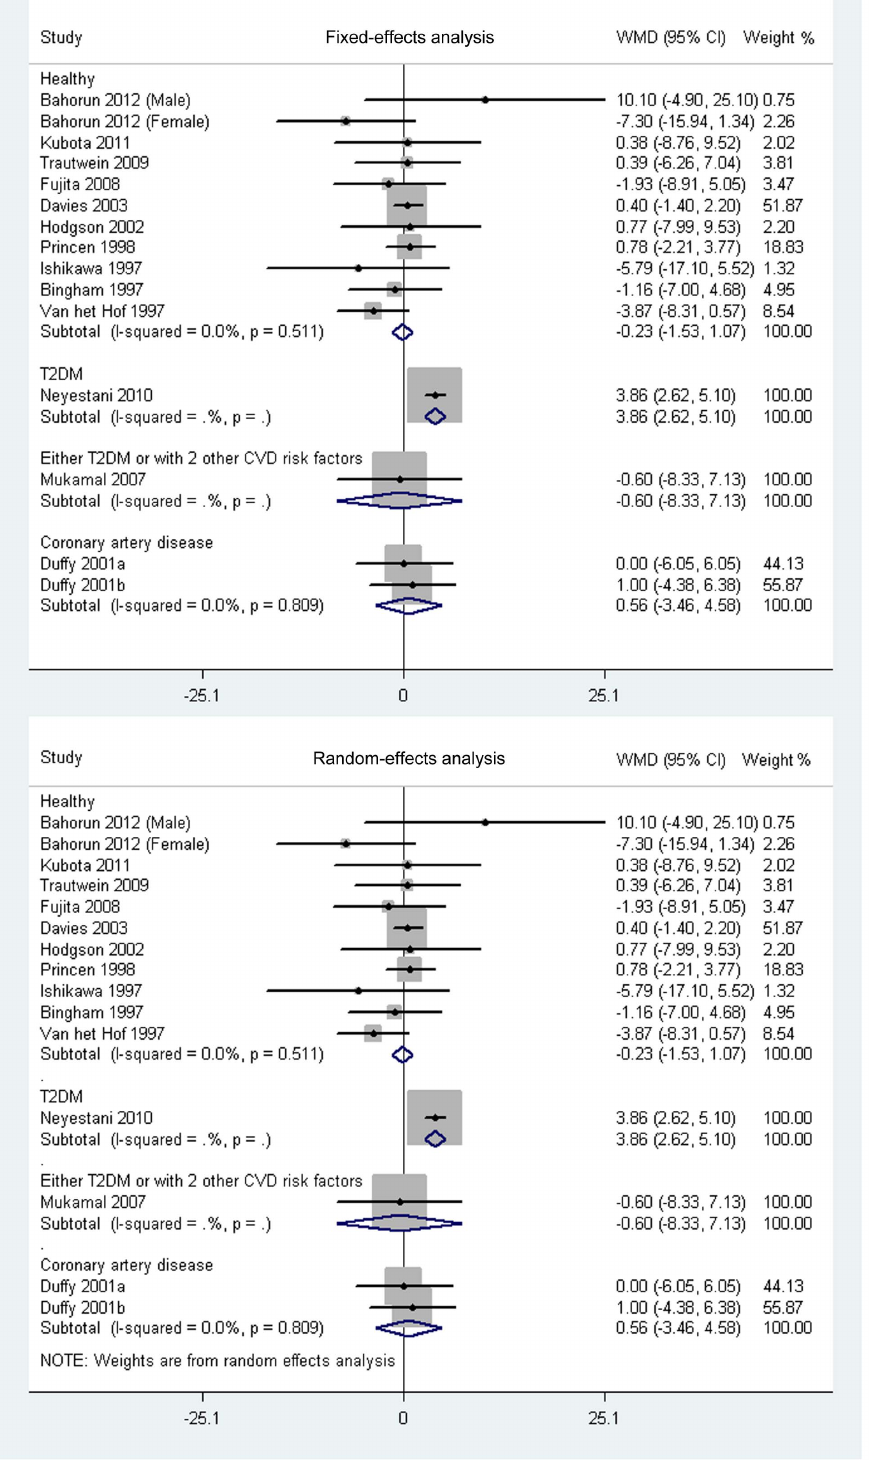
Figure 3. Meta-analysis of effects of black tea on concentrations of high-density lipoprotein-cholesterol (HDL-C). A meta-analysis was done with STATA software (Version 11; StataCorp, College Station, TX). Weight of each study was shown by sizes of data markers in the analysis. The diamond represents the overall estimated outcome and the results were calculated using a fixed-effects or random-effects model. WMD, weighted mean difference.